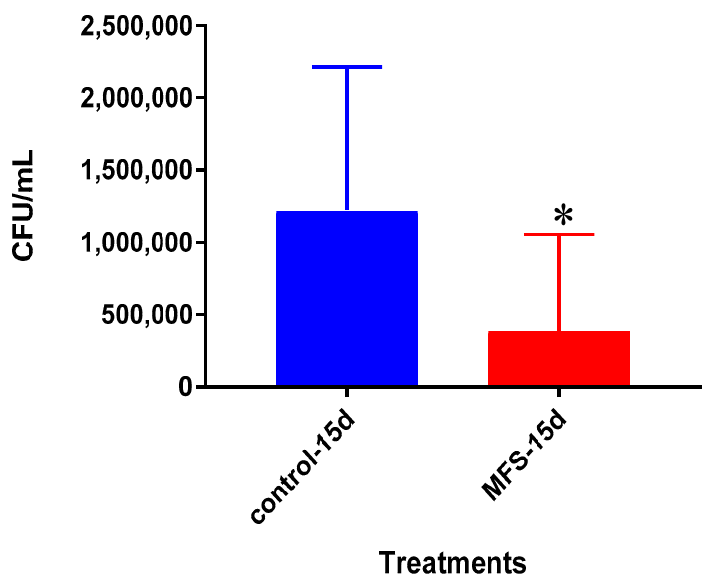
Figure 13. Survival Mtb Erdman inside untreated and MFS-treated granulomas from individuals with T2DM. Data represent means ± SE from six T2DM individuals. * p < 0.05 when comparing untreated samples with samples treated with MFS at 15 days.